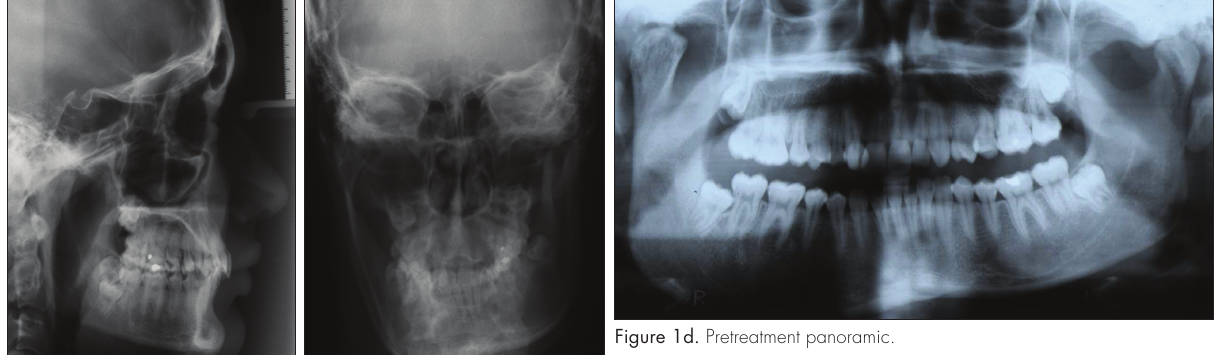
Figure 1d. Pretreatment panoramic.